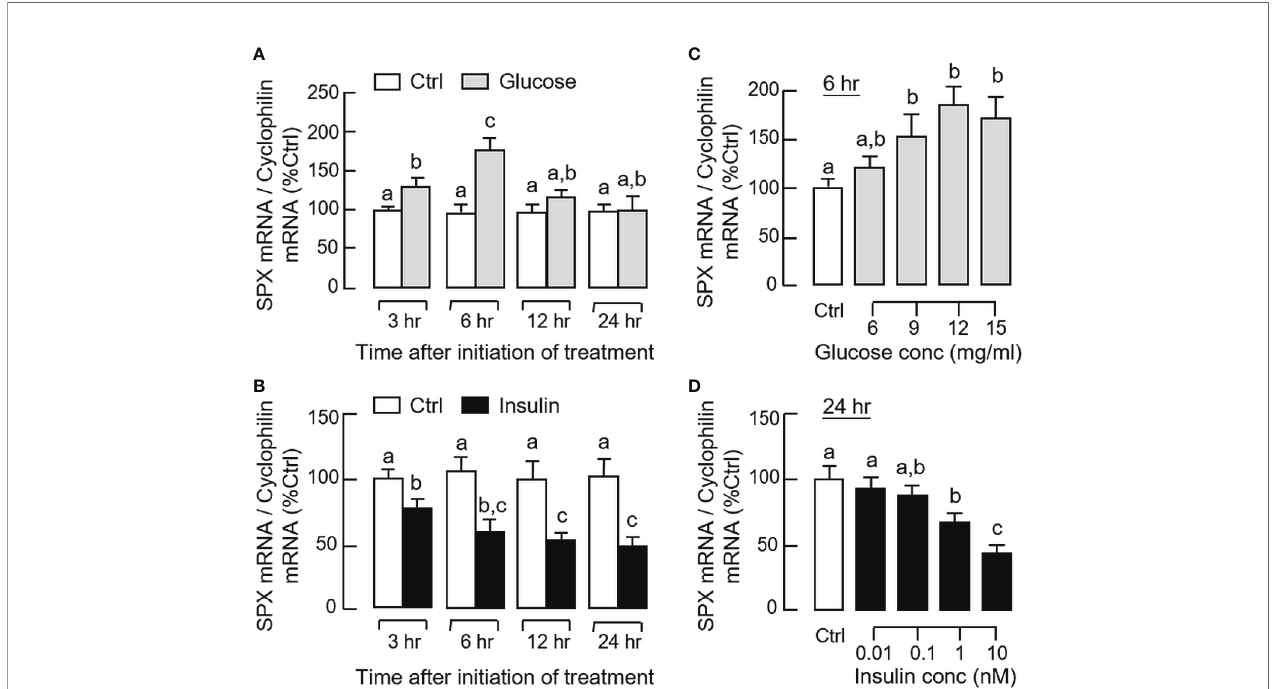
FIGURE 5 | Effects of glucose and insulin treatment on SPX gene expression in mouse gastric mucosal cells. Gastric mucosal cells were prepared from glandular stomach and incubated with (A) glucose (12 mg/ml) or (B) insulin (10 nM) for the duration as indicated. For dose dependence studies, the cells were treated with increasing levels of (C) glucose for 6 h and (D) insulin for 24 h, respectively. After treatment, total RNA was isolated and used for real-time PCR for SPX transcript. Data presented (mean ± SEM, N = 8) were analyzed by two-way ANOVA followed by Bonferroni test (for time course) or one-way ANOVA followed by Newman- Keuls test (for dose dependence), and groups denoted by different letters represent a signi fi cant difference at p <